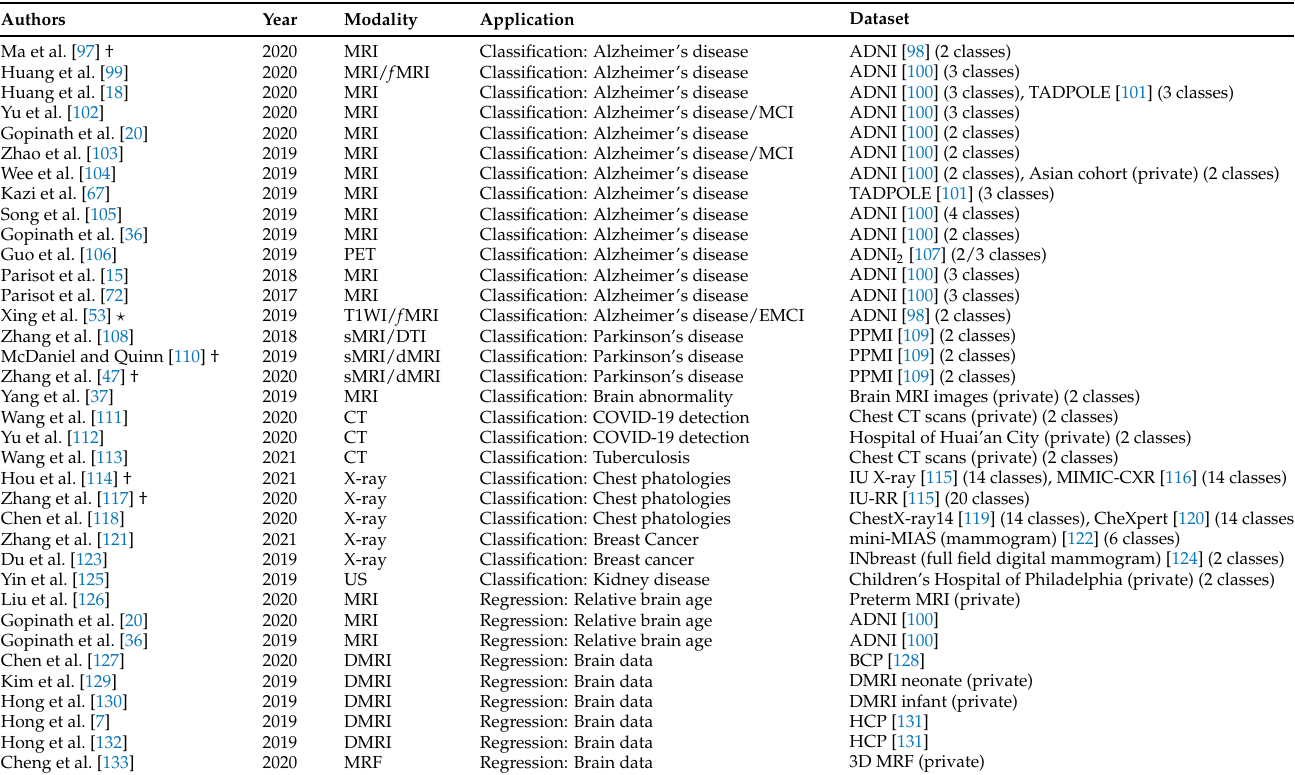
(cid:63) GCN with temporal structures for medical diagnostic analysis. † GCN with attention structures for medical diagnostic